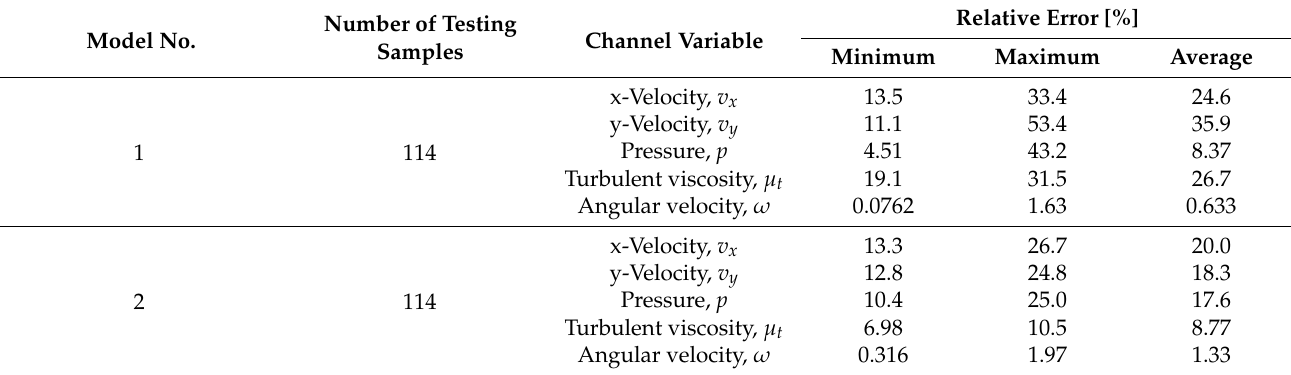
Table 9. Relative errors produced by Model 1 and Model 2, for the combined testing cases of v ∞ = 1.5, 2.0, and 2.5